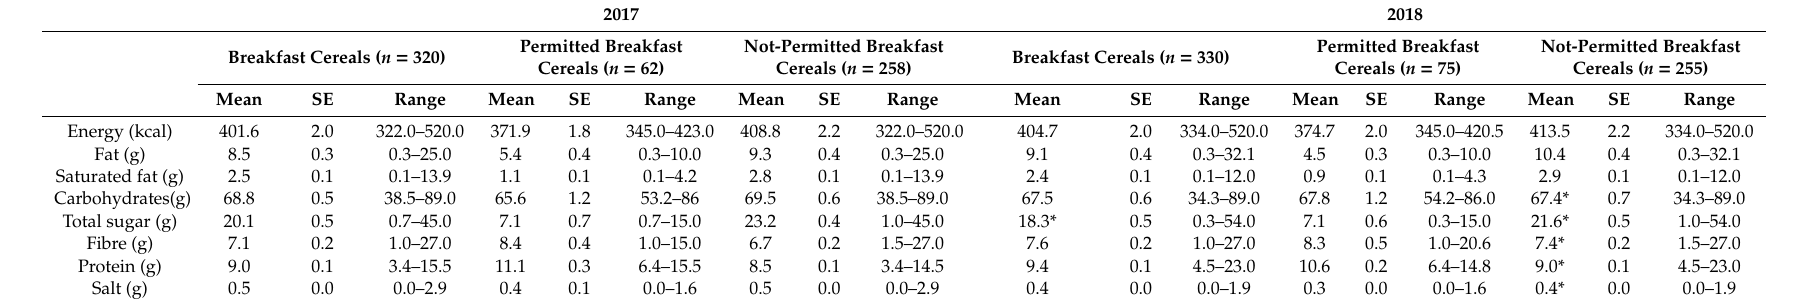
Table 1. Mean nutritional content per 100g of the included breakfast cereals (Mean + SE + range) (2017 and 2018)